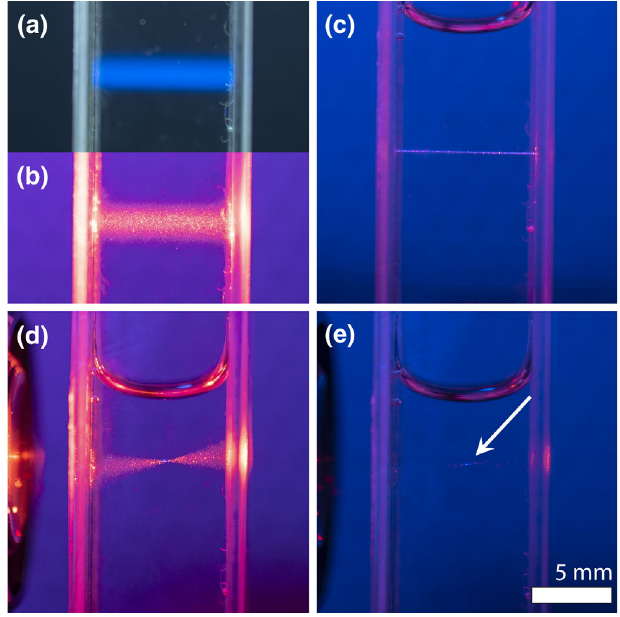
FIG. 4. Comparison of the illumination volume for linear CD and HRS optical activity in a glass cuvette containing a fluorescent solution (tonic water). In (a) and (b), illumination volume with a 2-mm-diameter beam at 400 and at 760 nm, respectively. In (c), multiphoton luminescence from the illumi- nation volume using the lens for our HRS experiments. In (d), 760-nm light focused with a × 50 long-working-distance objec- tive. In (e), corresponding multiphoton luminescence resulting from only the focal volume of